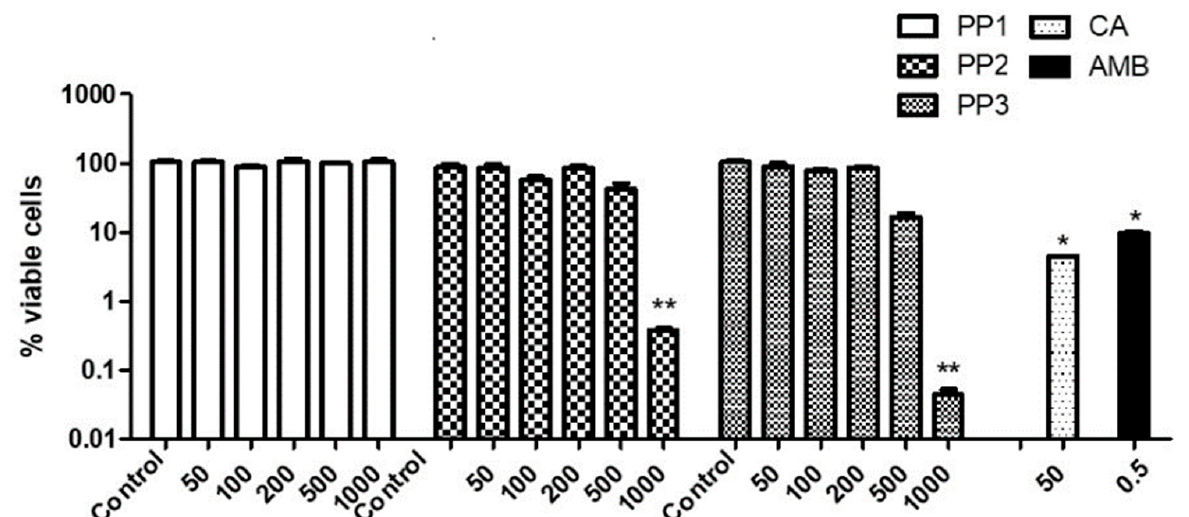
Figure 1. Cellular survival of C. neoformans H99 strain recorded upon exposure to several extracts of propolis or CA. Cells were grown on YPD until exponential phase (O.D. = 0.8–1.0). Samples of identical cell density (10 7 cells/mL) were exposed for 1 h at 37 °C to crude extracts of the indicated propolis in a range of 50–1000 µg/mL as well as to 50 µg/mL of carnosic acid. An untreated control was always run in parallel. Amphotericin B (AmB at 0.5 µg/mL) was introduced as positive control of fungicidal activity. Statistically significant differences (* = p < 0.05; ** = p < 0.01 with respect to an untreated control were tested using the Mann–Whitney U test.